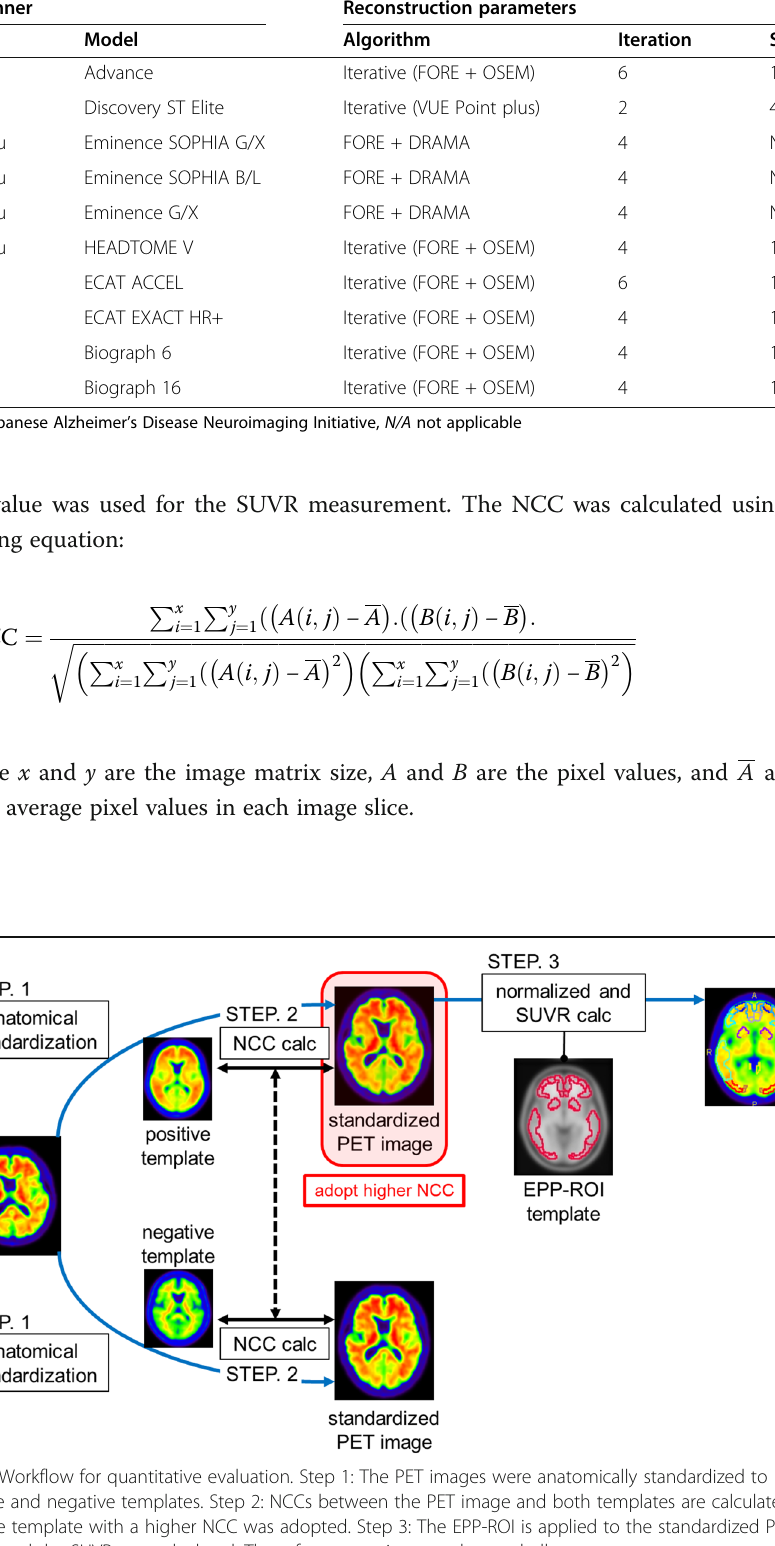
Table 2 PET scanners and reconstruction parameters used for 11 C-PiB PET in the J-ADNI study PET scanner